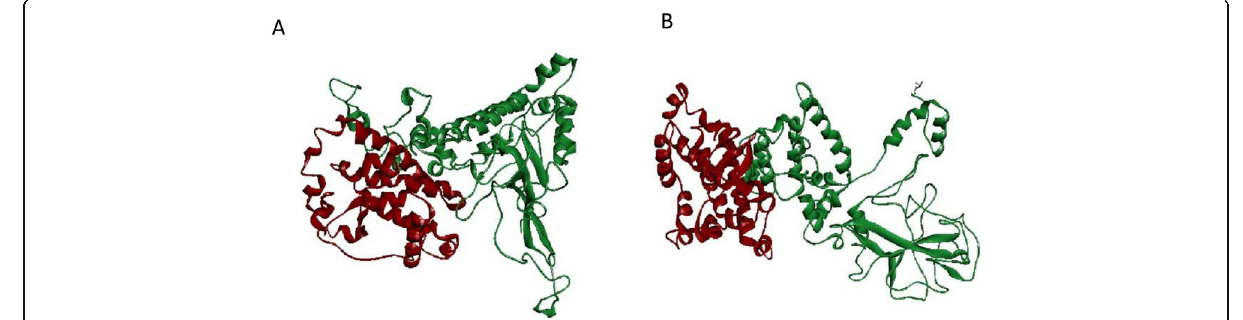
Fig. 2 A Bangladeshi isolate N & M-protein docking complex. B Wuhan wild type N &M-protein docking